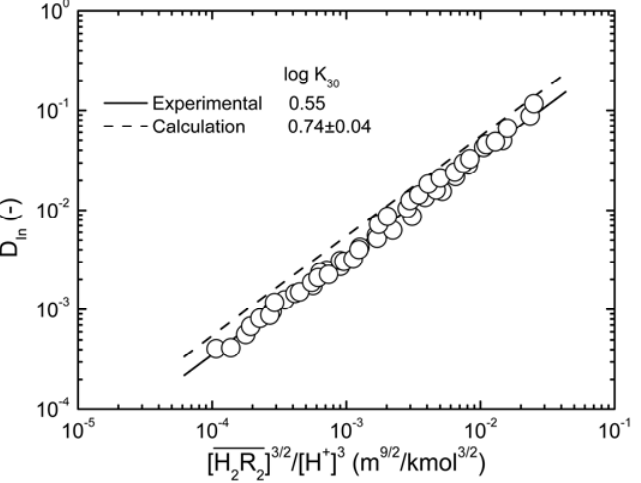
Figure 4. Log-plots of D concentrations in kerosene at 25 